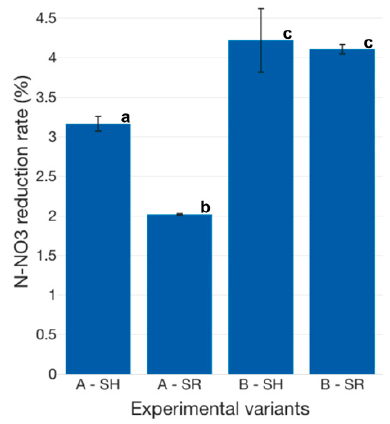
Figure 27. The N-NO 3 reduction rate and SE for each of the experimental variants (Tukey test)—